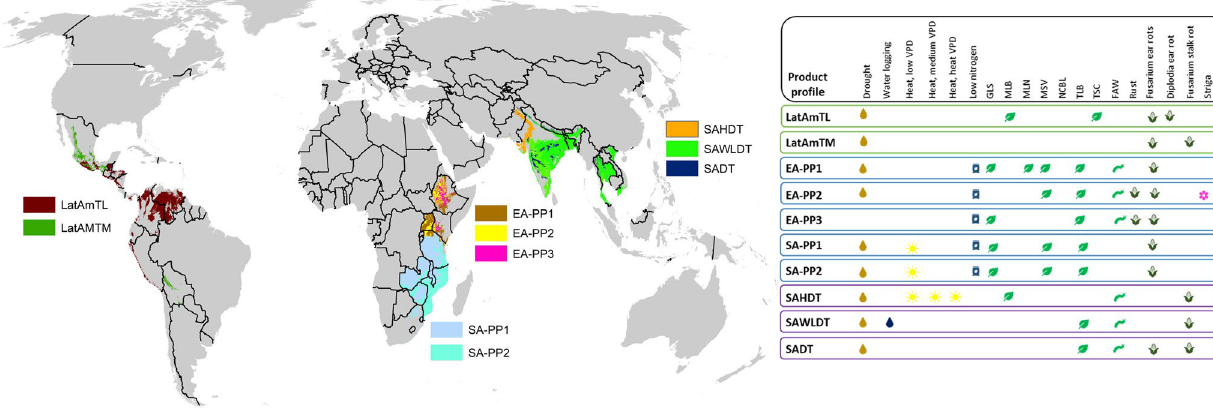
Figure 6. Overview of CIMMYT’s maize product profiles and the geographical area served by each of the breeding pipelines. Map created using ESRI (Environmental Systems Research Institute) ArcGIS Release 10.8.1 Redlands, CA, USA. Abbreviations: VPD, Vapour Pressure Deficit; GLS, Gray Leaf Spot; MLB, Maydis Leaf Blight; MLN, Maize Lethal Necrosis; MSV, Maize Streak Virus; TLB, Turcicum Leaf Blight; TSC, Tar Spot Complex; FAW, Fall